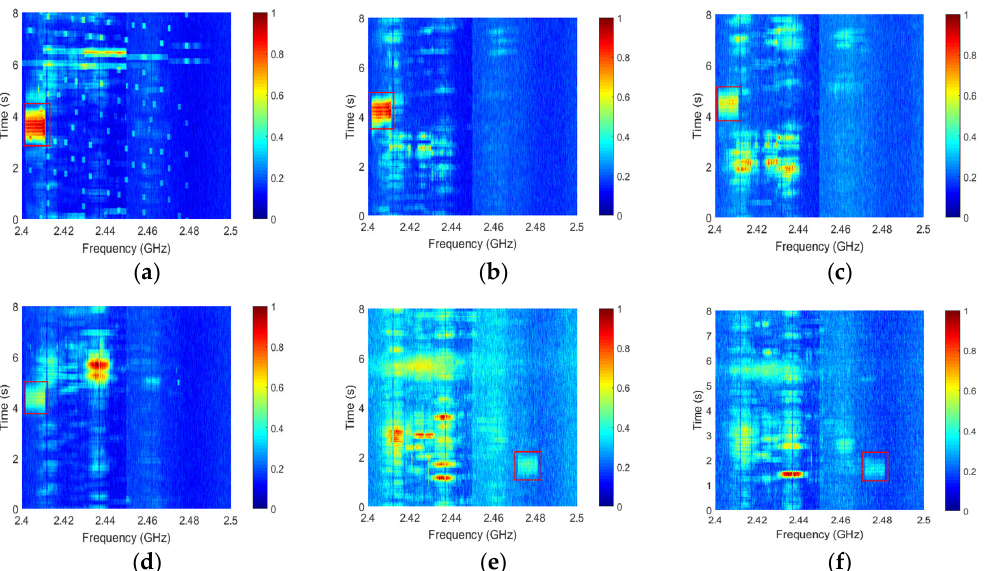
Figure 6. Normalized time–frequency matrices after filtering at outdoor distances of ( a ) 500 m, ( b ) 1000 m, ( c ) 1500 m, ( d ) 2000 m, ( e ) 2500 m, and ( f ) 3000 m.